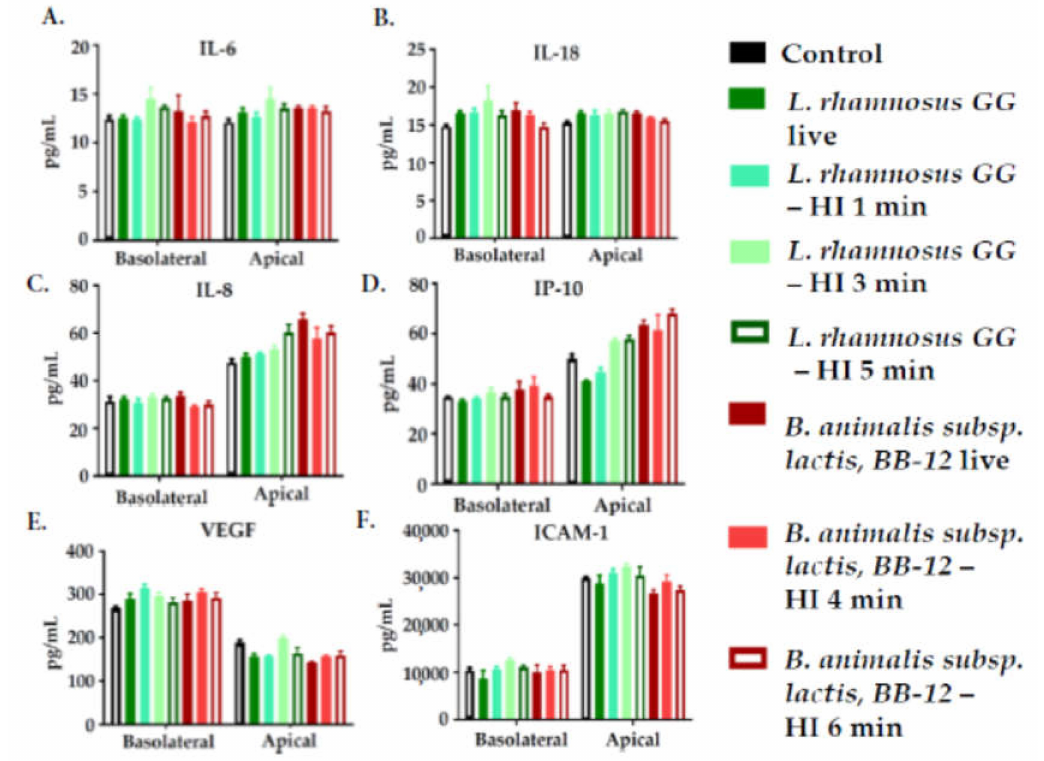
Figure 2. Concentrations (pg / mL) of IL-6 ( A ), IL-18 ( B ), IL-8 ( C ), IP-10 ( D ), VEGF ( E ), and sICAM-1 ( F ) in the apical and the basolateral medium of Caco-2 cells treated on the apical side with live or heat-inactivated (HI) L. rhamnosus GG or B. animalis subsp. lactis, BB-12 for 22 h. Data are mean + SEM ( n = 4). Data for apical and basolateral sides were analyzed separately by one-way ANOVA (all p > 0.05).